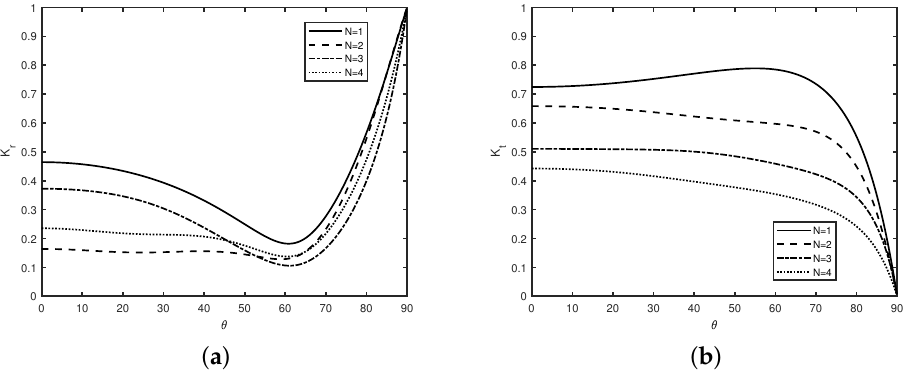
Figure 10. Variation of ( a ) reflection coefficient K r and ( b ) transmission coefficient K t versus angle θ for different values of N with breakwater width w / h 1 = 1.0, h 2 / h 1 = 0.25, d / h 1 = 2, C f = 0.5, and N = 4.